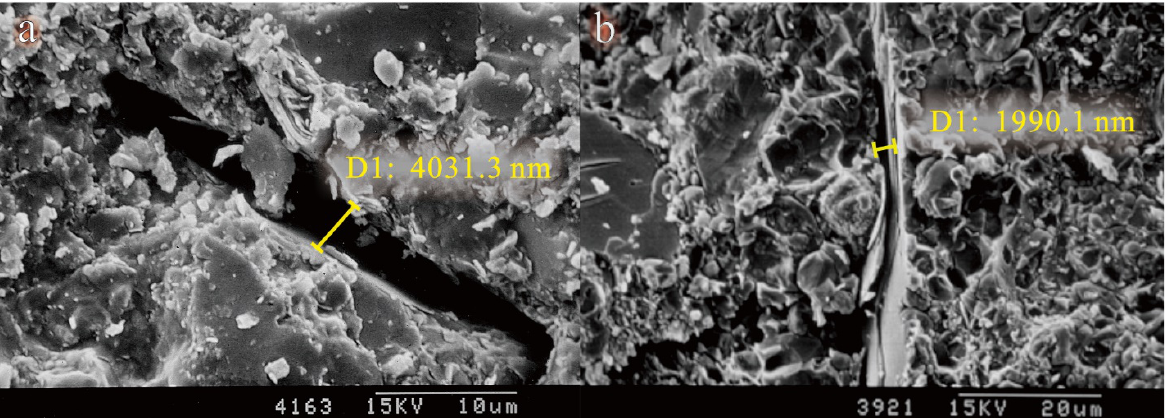
Figure 10. Microfractures in shale reservoirs of the Wufeng-Longmaxi Formation and Niutitang Formation in northern Guizhou Province. ( a ) DY1-S77 microfracture; ( b ) ZY1-S87 microfracture.